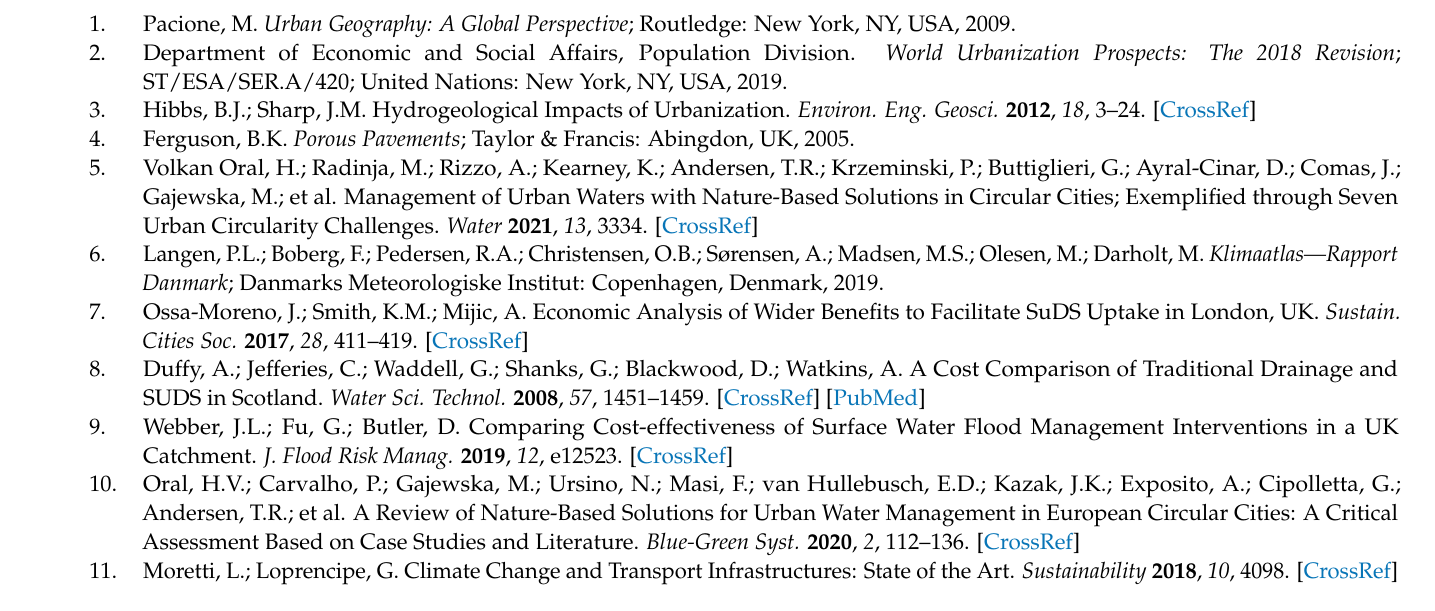
Figure 6. Energy produced and COP values from the Climate